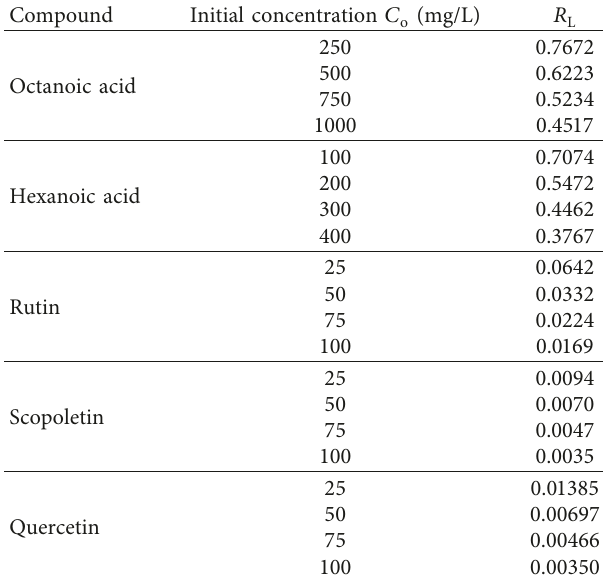
Table 9: R values for Amberlite IRA 67 on the adsorption of L organic acids and phenolic